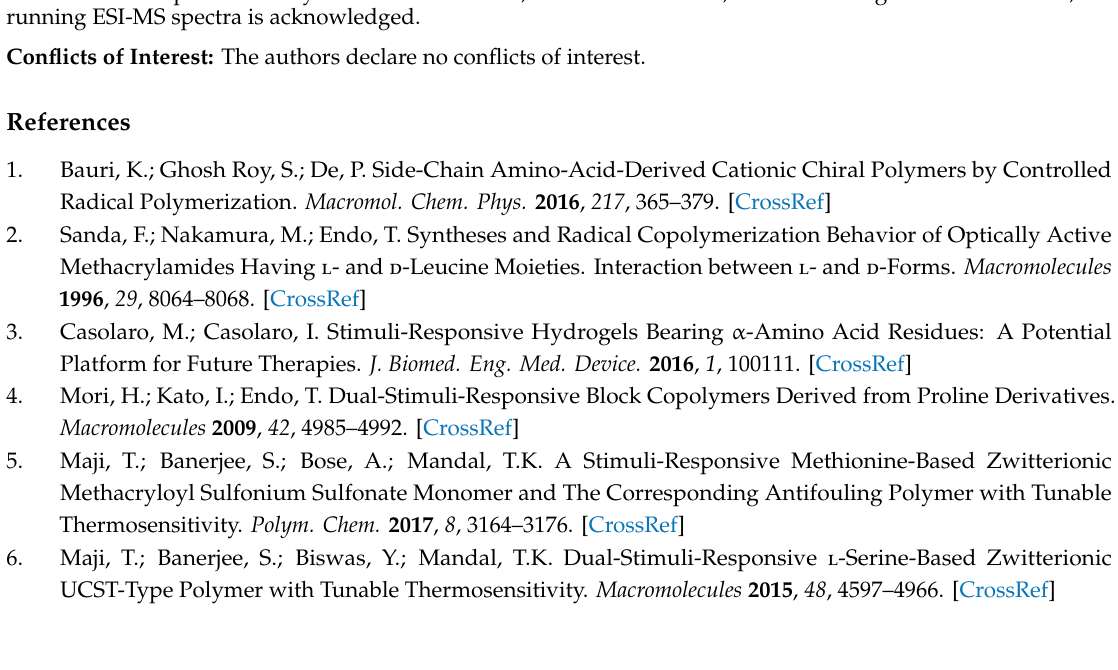
Figure S14: Positive ionization mode ESI-MS spectrum of MArMArM. Figure S15: Negative ionization mode ESI-MS spectrum of AlMAl. Figure S16: Negative ionization mode ESI-MS spectrum of MAlMAlM. Figure S17: Negative ionization mode ESI-MS spectrum of ArMAlMAlMAr. Figure S18: Snapshot of the OminiSEC 4.2 software output showing the results of SEC analysis of the [MArM-Pip] n copolymer carried out at pH 8.00 ± 0.05 0.1 M Tris bu ff er solution with 0.2 M sodium chloride. The operational conditions were: sample concentration 20 mg mL − 1 ; flow rate 1 mL min − 1 ; injection volume 20 µ L; column dimensions 300 × 7.5 mm 2 , temperature 25 ◦ C. Figure S19: Snapshot of the OminiSEC 4.2 software output showing the results of SEC analysis of the [MArMArM-Pip] n copolymer carried out at pH 8.00 ± 0.05 0.1 M Tris bu ff er solution with 0.2 M sodium chloride. The operational conditions were: sample concentration 20 mg mL − 1 ; flow rate 1 mL min − 1 ; injection volume 20 µ L; column dimensions 300 × 7.5 mm 2 , temperature 25 ◦ C. Green line: light-scattering trace, red line: refractive index